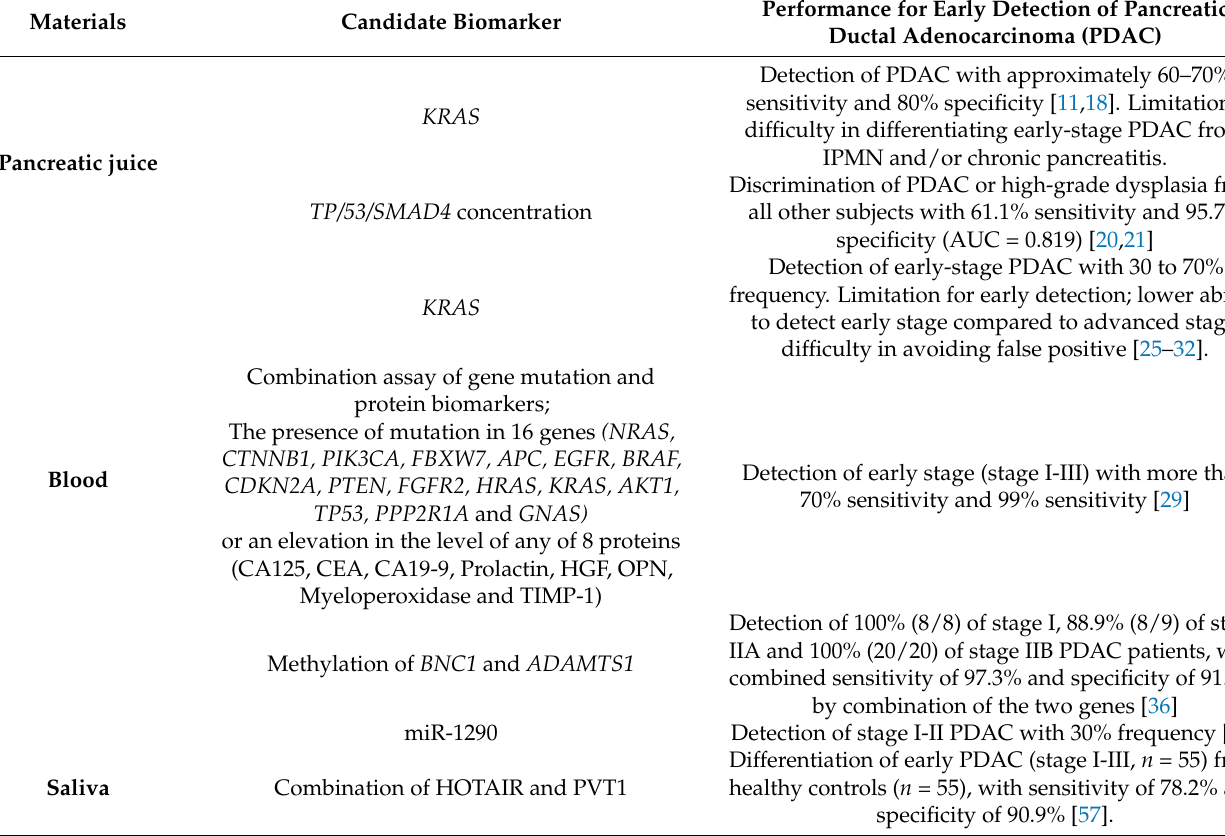
Table 1. Summary of candidate biomarkers for early detection of pancreatic ductal adenocarcinoma in body fluids by molecular